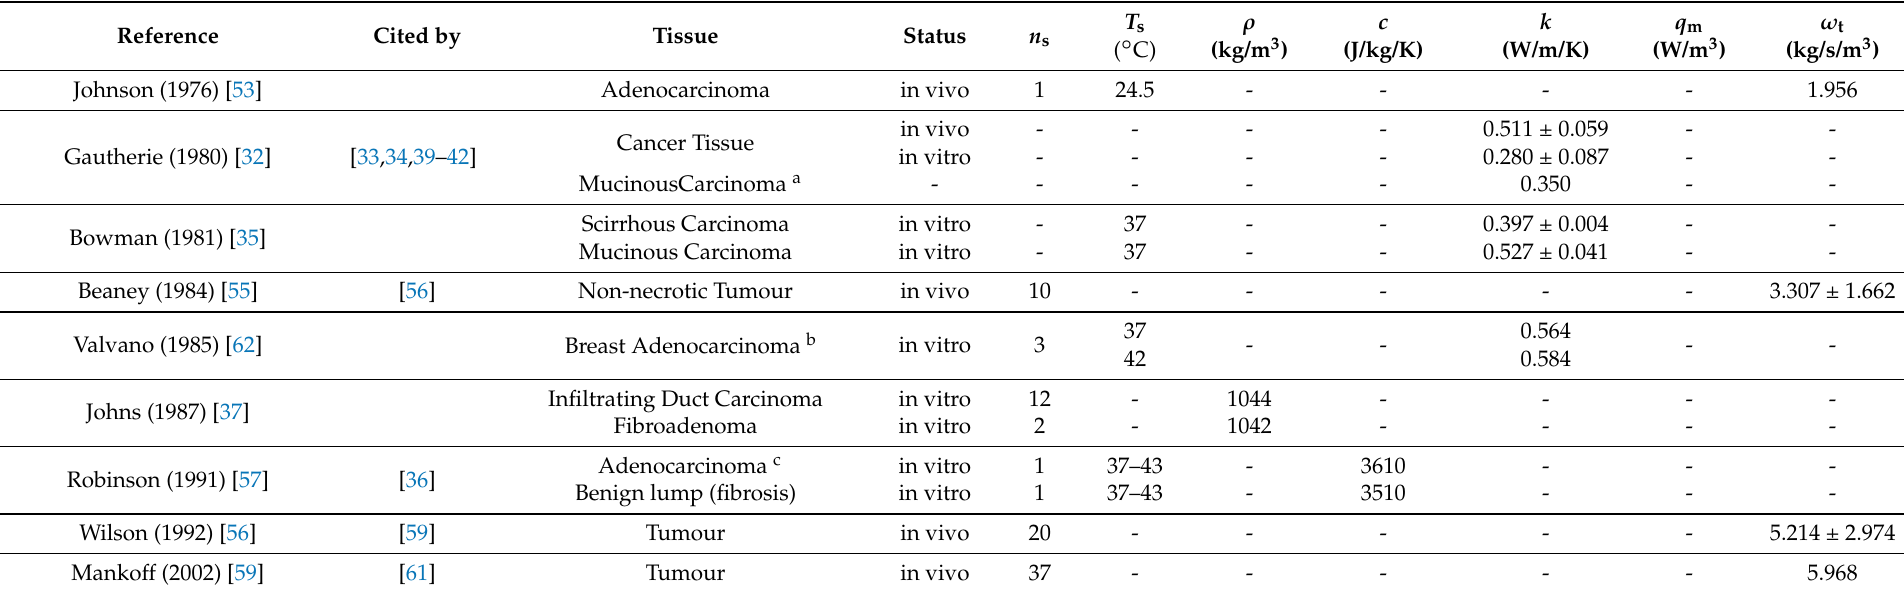
Table 5. Thermal and physiological properties of human breast tumours resulting from experimental